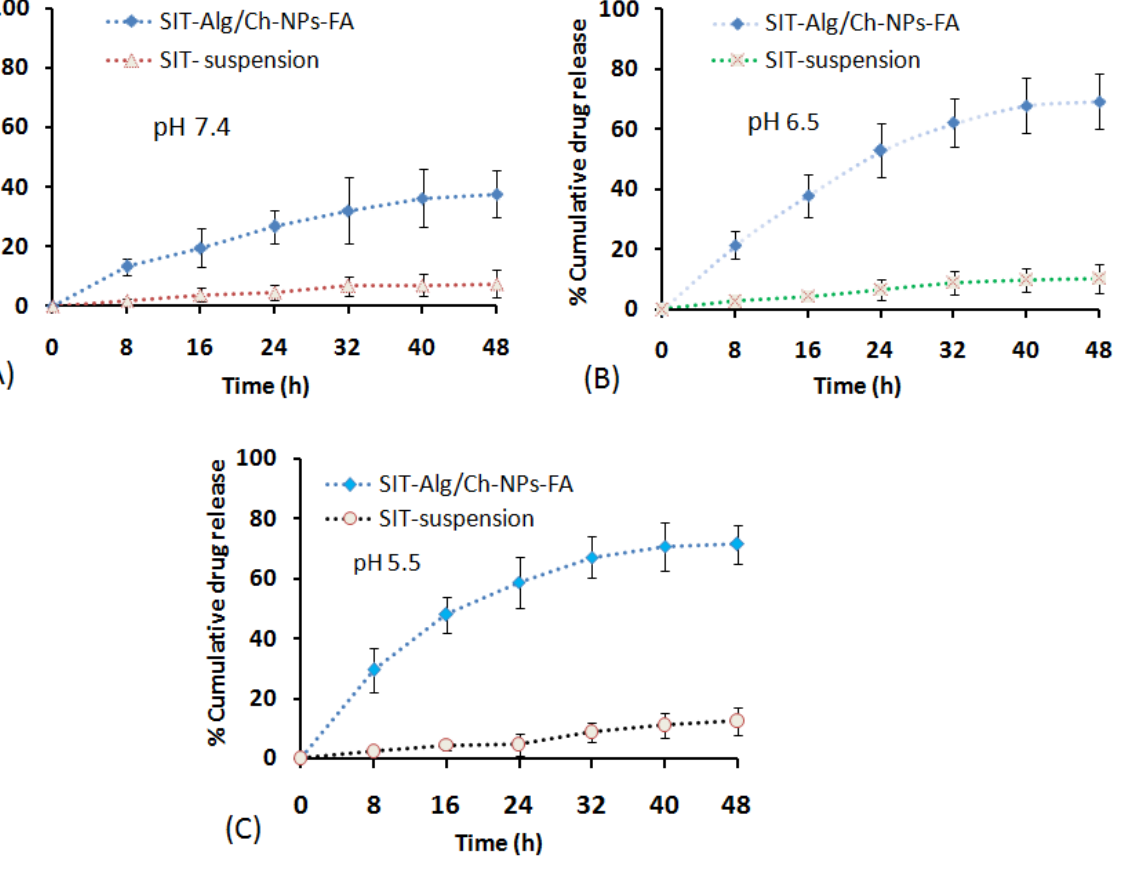
Figure 6. %Cumulative β -SIT release from SIT-Alg/Ch-NPs-FA and β -SIT-suspension in dissolution medium of different pHs: 7.4 ( A ); pH 6.5 ( B ); and pH 5.5 ( C ) at various time intervals of 0, 8, 16, 24, 32, 40, and 48 h, respectively.